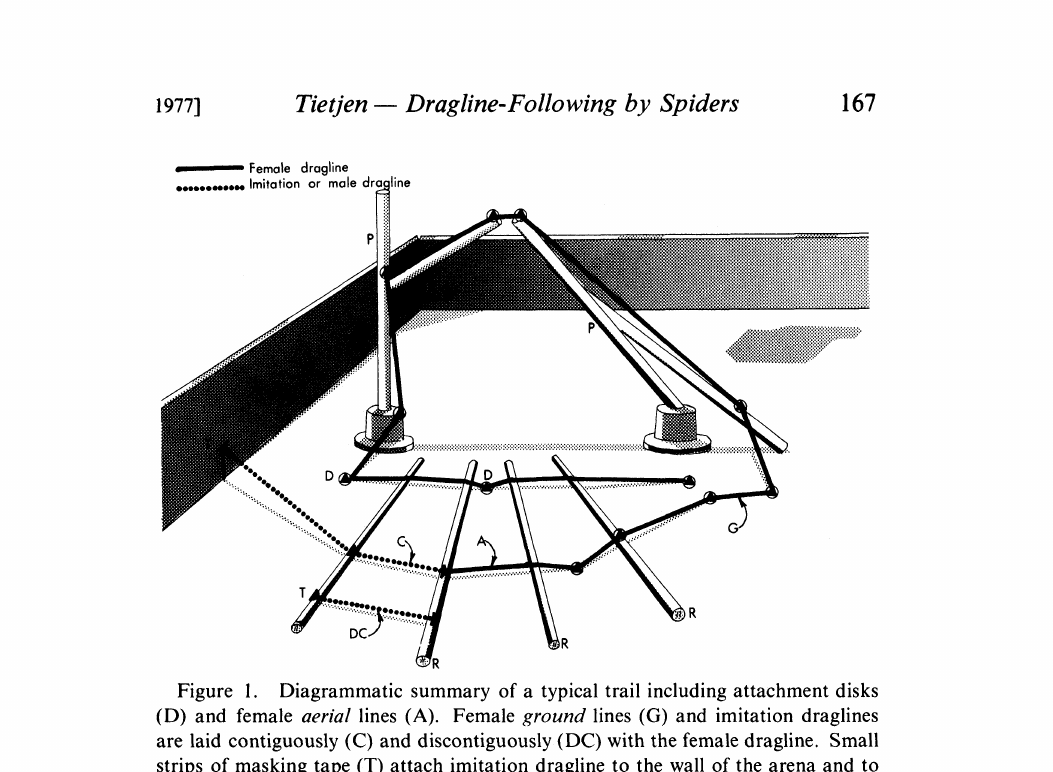
Figure 1. Diagrammatic summary of a typical trail including attachment disks (D) and female aerial lines (A). Female ground lines (G) and imitation draglines are laid contiguously (C) and discontiguously (DC) with the female dragline. Small strips of masking tape (T) attach imitation dragline to the wall of the arena and to 5-mm diameter glass rods (R). Glass rods were usually parallel and 9-11 cm apart. When artificial "plants" (P) were incorporated into the experiment, female trails up to 236 cm in length were